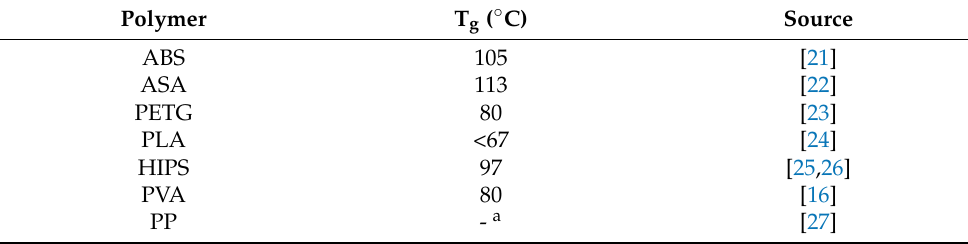
Table 1. Glass transition temperatures of pre-selected polymers.